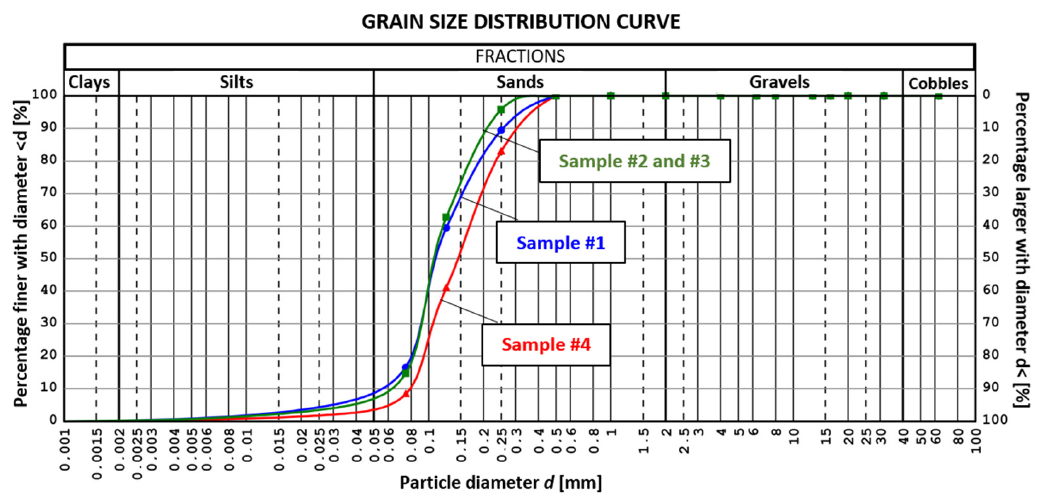
Figure 6. Grain size distribution curves of mineral residues from burning peat samples.